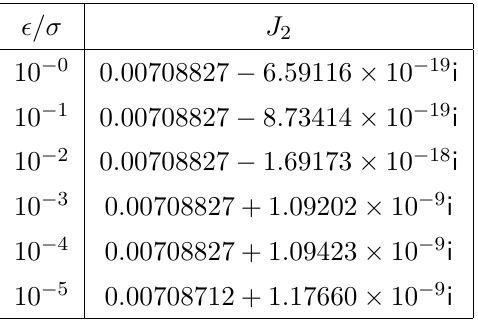
Table 2 . Values of J 2 using Method 2 (numerical contour) as (cid:15)